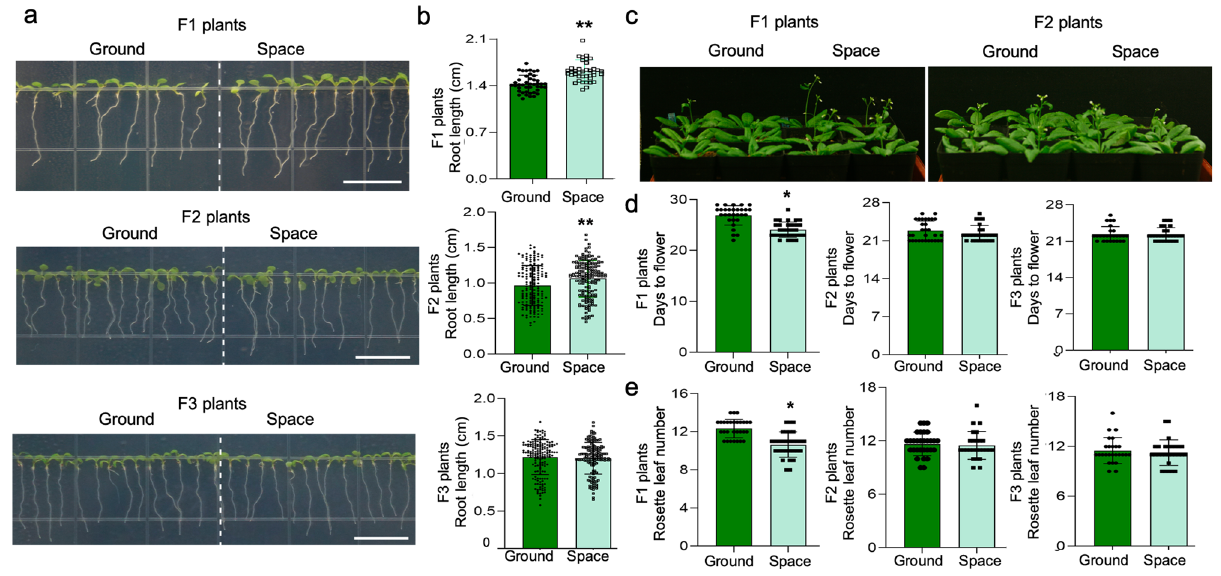
Fig. 2 Comparison of the root length, rosette leaf number, and fl owering time phenotypes in the offspring of space fl ight and ground control plants. a , b The length of primary roots of seven-day-old seedlings in the successive F 1 and F 3 generations of space fl ight and ground control samples ( n > 40 for F1 generation, n > 150 for F3 generation), and the length of primary roots of six-day-old seedlings in the F 2 generation ( n > 160); Scale bar indicates 1 cm. c – e The fl owering time analysis of the three successive F 1 , F 2 , and F 3 generations of space fl ight and ground control samples ( n > 30 for each generation). The error bar is the standard deviation. An asterisk *indicates a statistically signi fi cant difference between the space fl ight and control samples using Student ’ s two-tailed t- test ( p < 0.05).